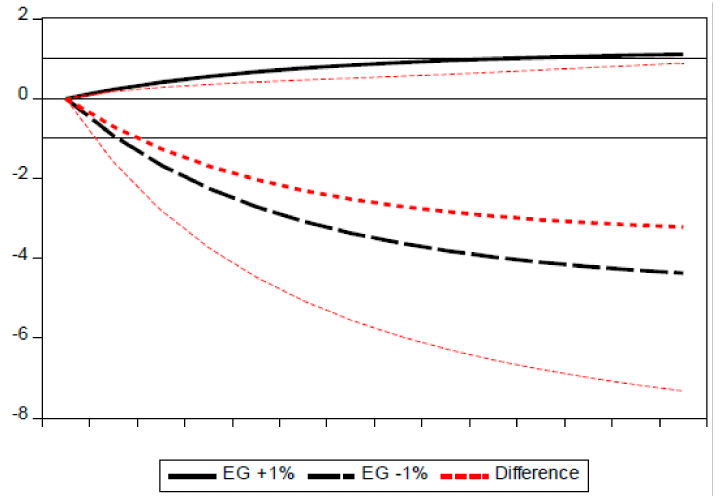
Figure 4. Dynamic multiple adjustments of carbon emission to a unitary variation of economic growth in